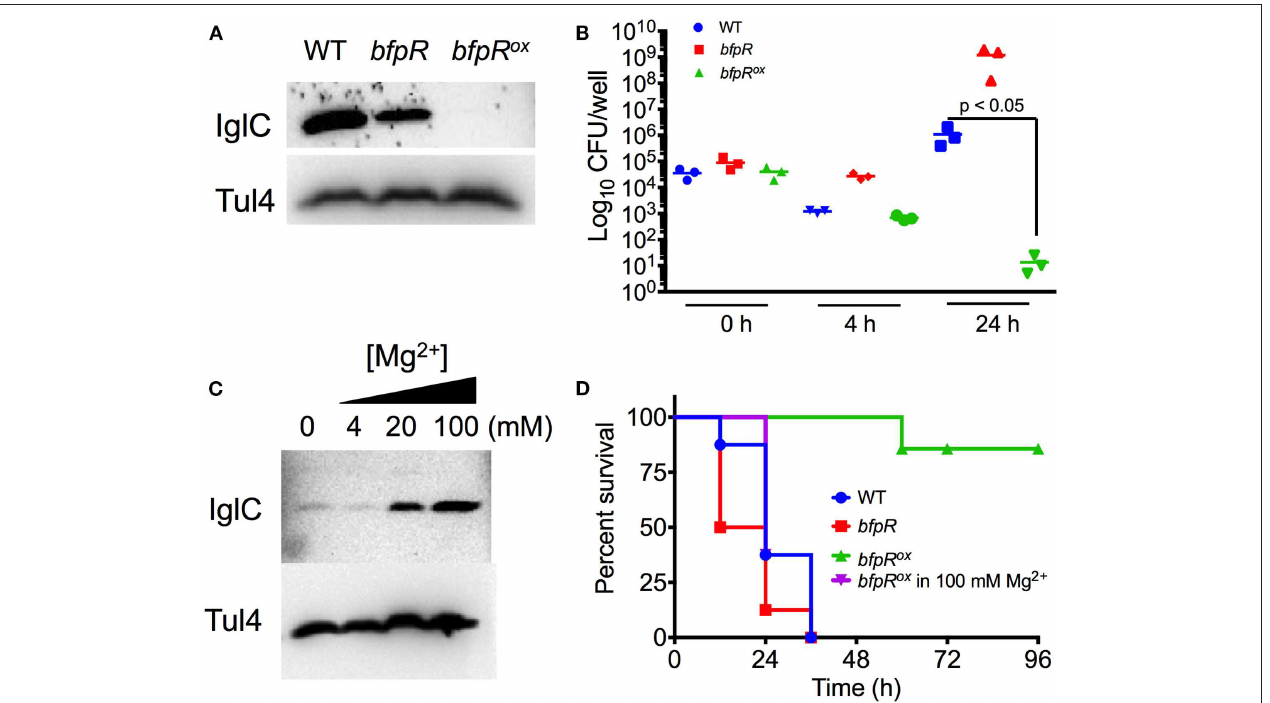
FIGURE 8 | bfpR mutation and overexpression affects intracellular replication and virulence. (A) Western blot for IglC protein expression in WT, bfpR , and bfpR ox . (B) Confluent cultures of PMA-differentiated U937 human monocytes were infected (MOI 50). Following the gentamicin protection protocol, CFU was determined. (C) Western blot showing IglC expression in the bfpR ox with increasing concentrations of Mg 2 + . Tul4 was probed as a control protein. (D) Galleria mellonella were injected with equal CFUs. Caterpillars were observed twice daily for survival status. Data are shown as averages from three independent experiments and significance was determined by Student’s t -test or log-rank test. The difference between bfpR ox and the wild type is highly significant, p <